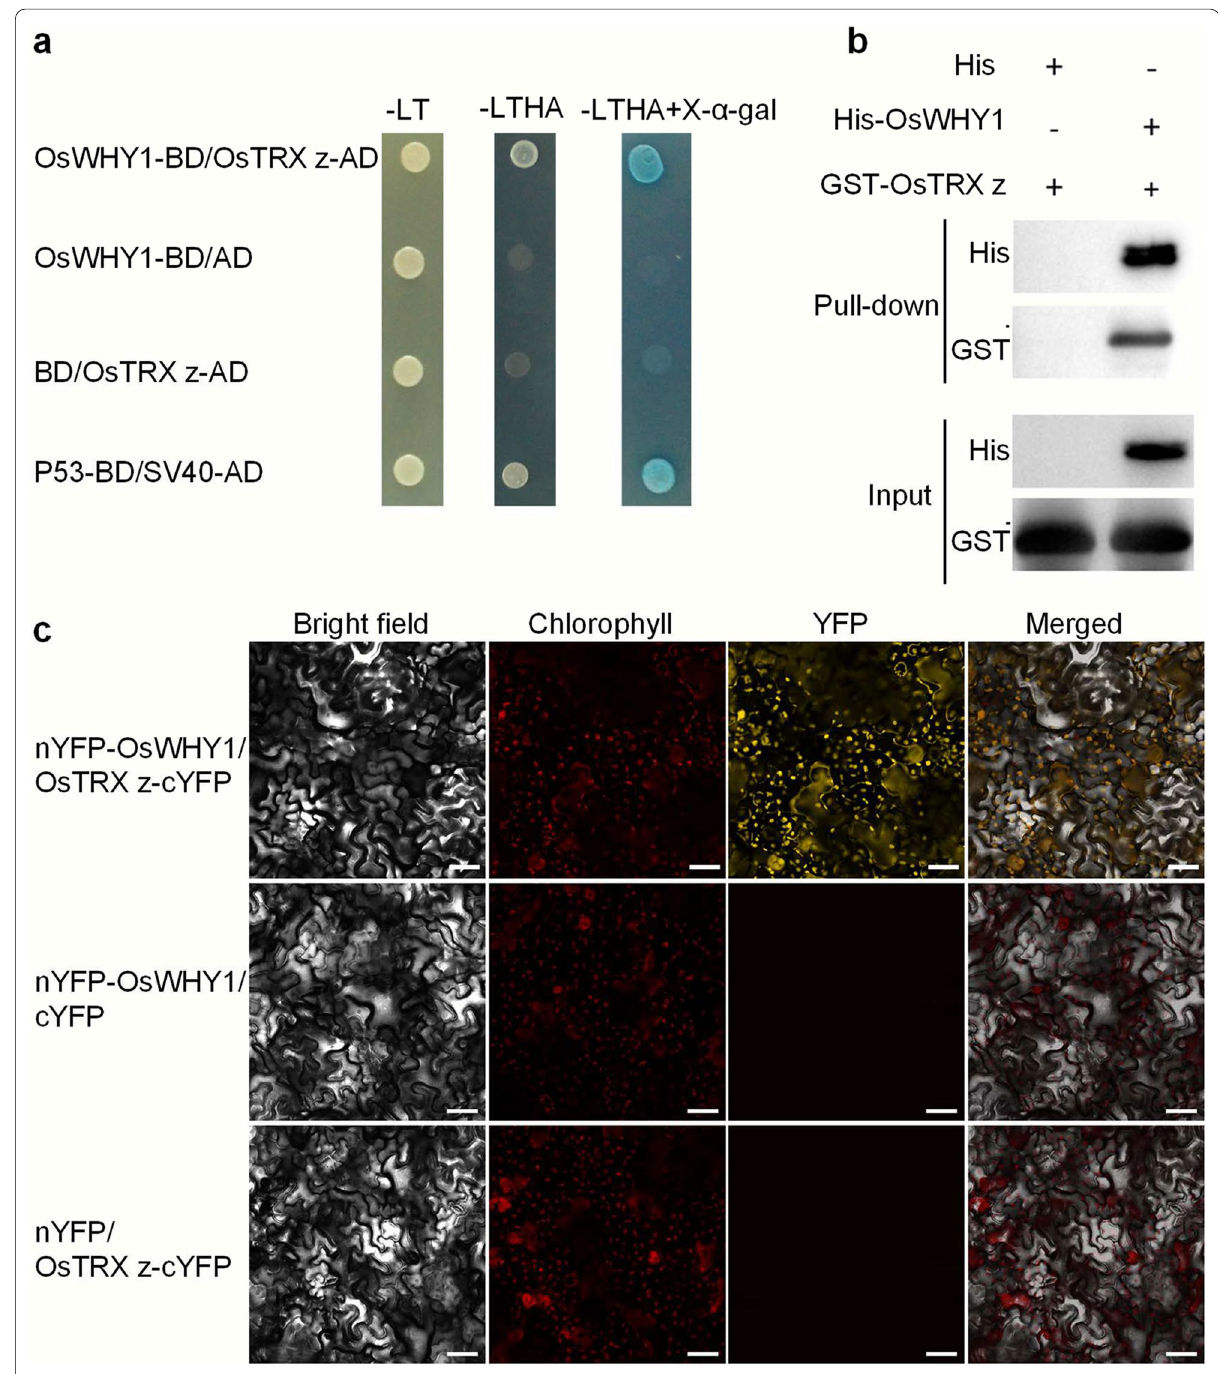
Fig. 1 OsWHY1 interacts with OsTRX z in vitro and in vivo . a Interaction of OsWHY1 and OsTRX z in yeast two-hybrid assays. -LT: selective medium (SD/-Leu/-Trp); -LTHA: selective medium (SD/-Leu/-Trp/-His/-Ade); -LTHA X-α-gal: selective medium (SD/-Leu/-Trp/-His/-Ade) containing X-α-gal. + P53-BD and SV40-AD were used as positive controls. b Pull-down assays for detection of interaction of His-OsWHY1 and GST-OsTRX z in vitro. c Bimolecular fluorescence complementation (BiFC) assays demonstrating that OsWHY1 interacts with OsTRX z in Nicotiana benthamiana leaf cell chloroplasts. Bar 50 =